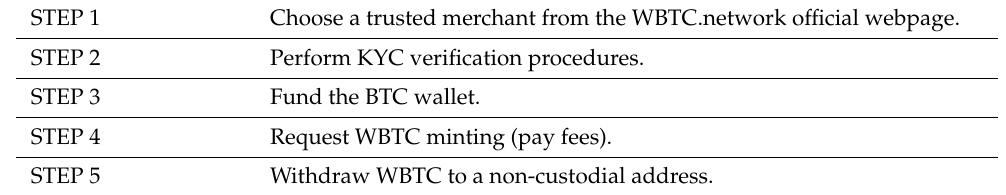
Table 3. WBTC centralized